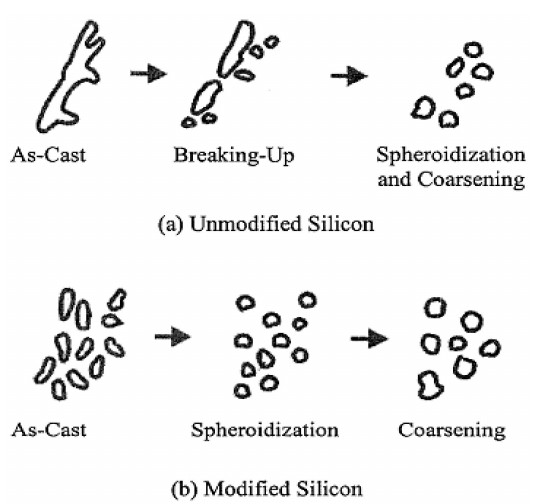
Figure 5. Schematic characterization of the three stages of spheroidization and coarsening of the eutectic silicon phase in the case of ( a ) unmodified; and ( b ) modified Al-Si alloy [20].